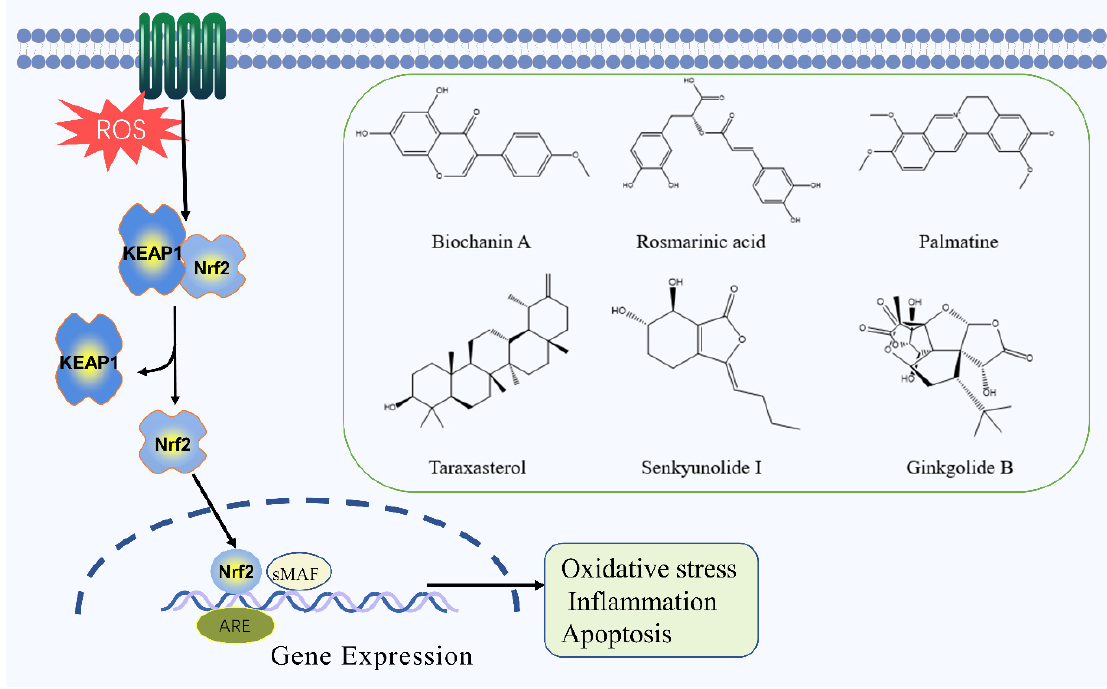
Figure 5. Nrf2 signaling pathway and the chemical structure of natural compounds.